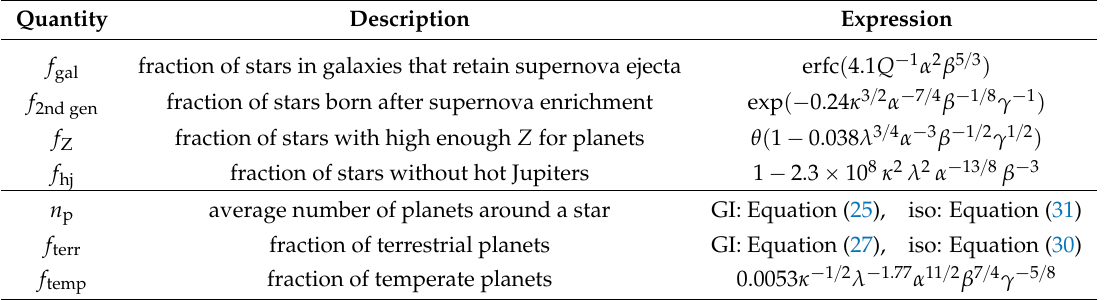
Table 1. The quantities computed in this work. Here, Q is the amplitude of perturbations, κ parameterizes the density of galaxies, λ parameterizes stellar size, GI stands for giant impact formation mechanism, and iso stands for isolation production